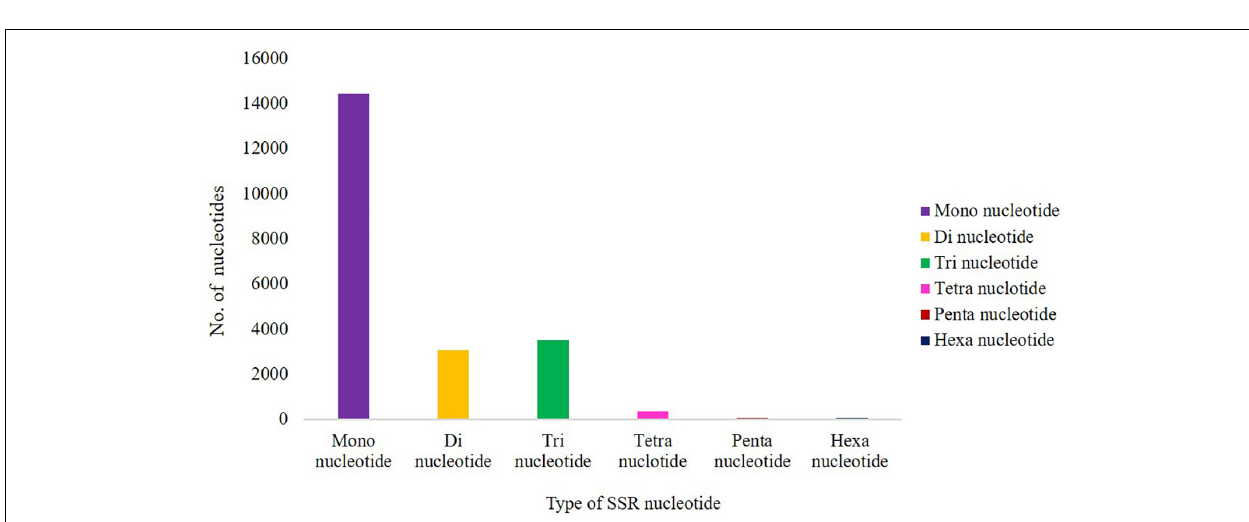
FIGURE 4 | (A) Upregulated transcription factor families of drought-stressed cluster bean cultivar RGC-1025. (B) Heatmap of the top 40 upregulated transcription factors of cluster bean cultivar RGC-1025 in drought stress. (C) Downregulated transcription factor families of drought-stressed cluster bean cultivar RGC-1025.